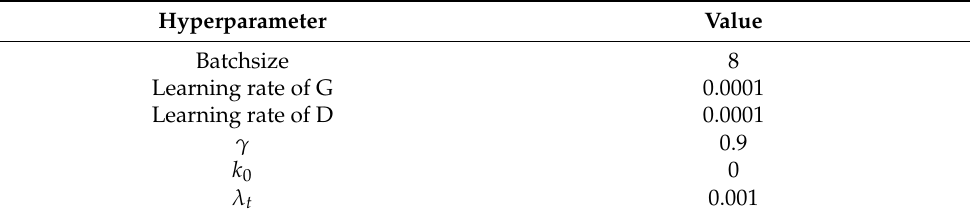
Table 1. The training hyperparameters of CBEGAN.